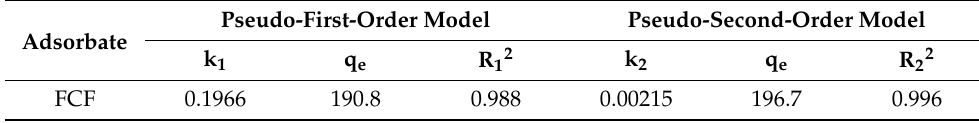
Table 2. Adsorption kinetics simulation